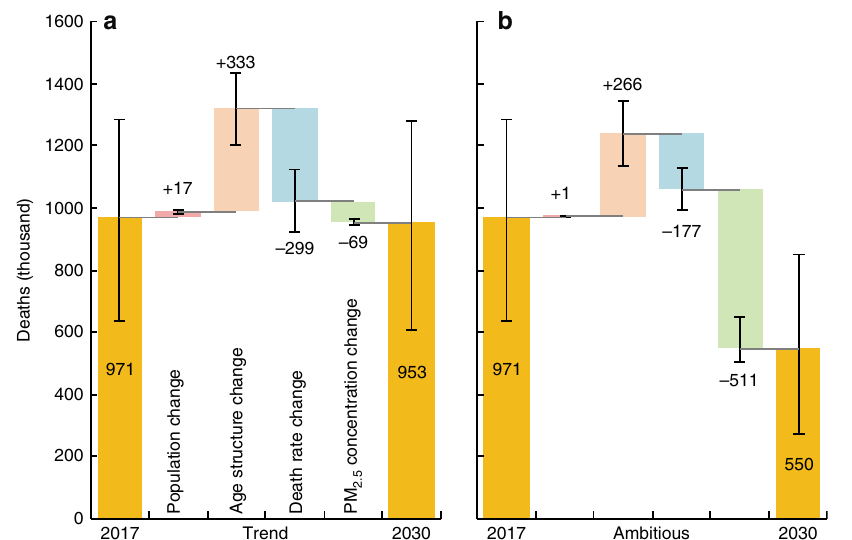
Fig. 4 Changes in deaths attributable to PM 2.5 pollution from 2017 to 2030 under different scenarios. a Following the current trend (population ‐ weighted PM 2.5 will be 35 μ g m − 3 in 2030). b Taking a more ambitious target (population ‐ weighted PM 2.5 will be 10 μ g m − 3 in 2030). The effects of changes in population, age structure and death rates are different between the two scenarios because they are jointly affected by the changes in PM 2.5 concentration (see Methods for details). Error bars represent 90% con fi dence intervals. Source data are provided as a Source Data fi